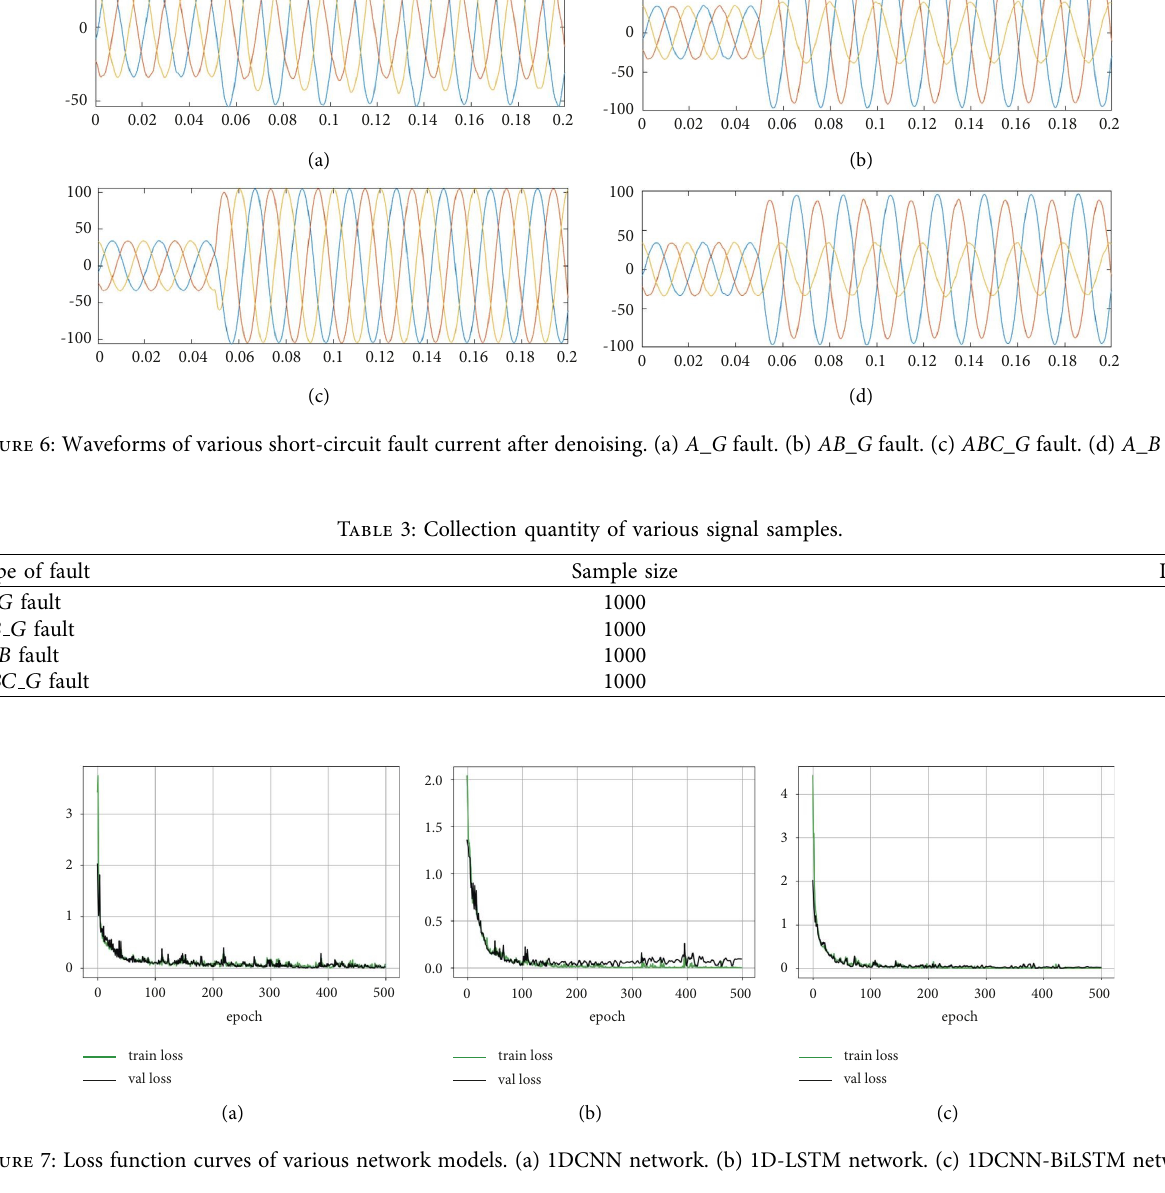
0.20.40.60.81.0